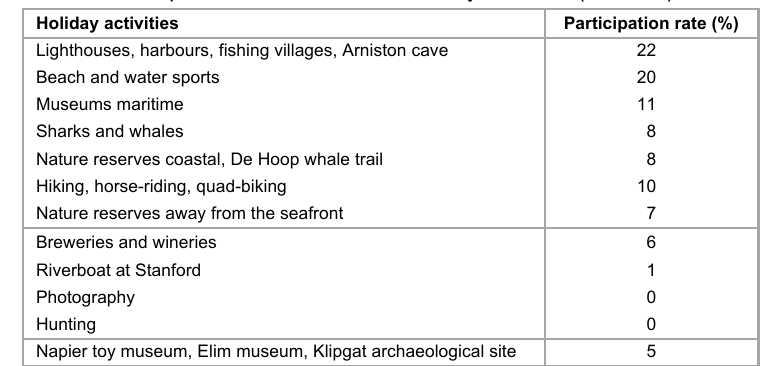
Participation rates in selected holiday activities (n=3